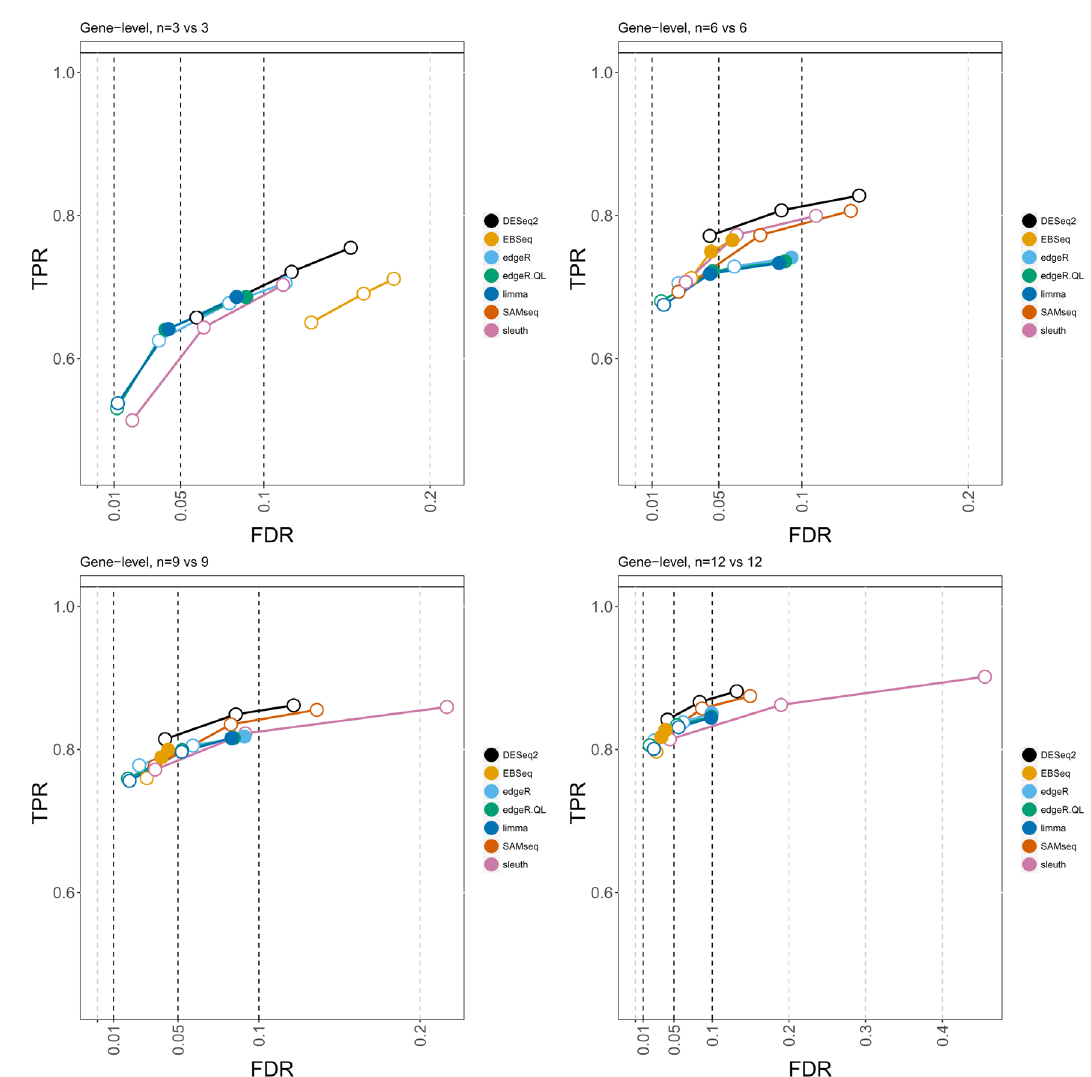
Figure 13. True positive rate over false discovery rate for differential gene expression of the simulated dataset. The four panels are for per-group sample sizes: 3, 6, 9, and 12, as indicated in the title. The y-axis remains fixed but the x-axis changes scale in the bottom